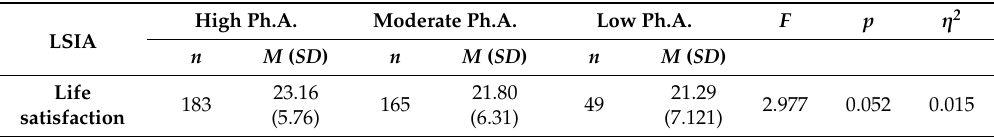
Table 1. Means, standard deviations and one-way ANOVA of the participants’ scores on the life satisfaction scale (LSIA) based on their level of physical